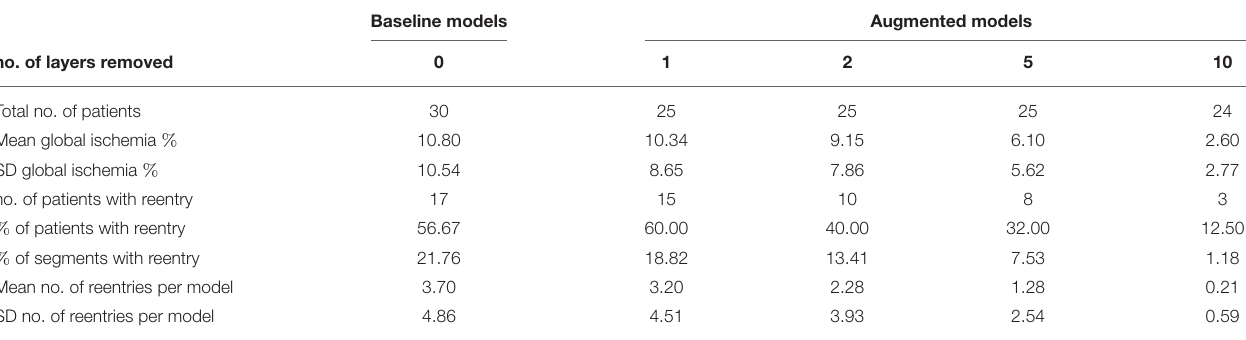
TABLE 1 | Summary of arrhythmia simulation